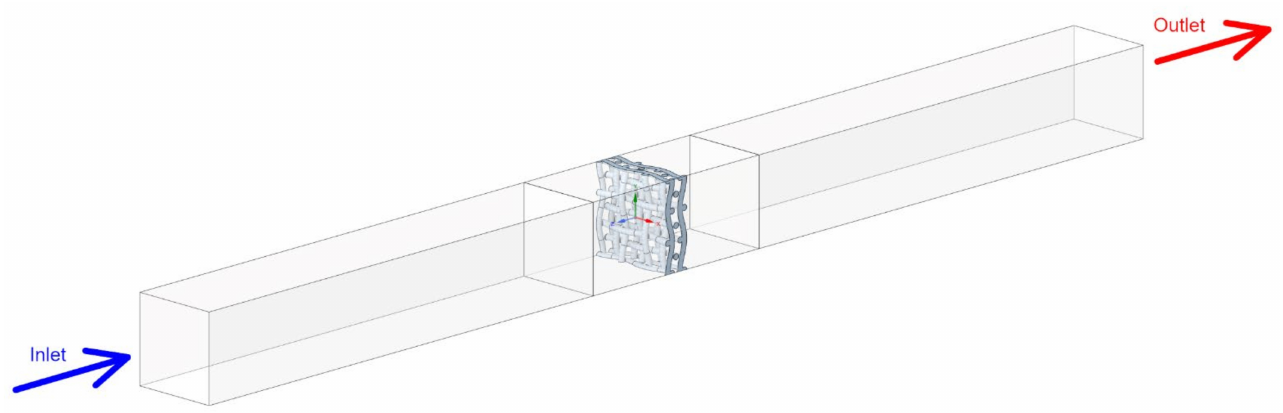
Figure 3. Computational domain of Geometry